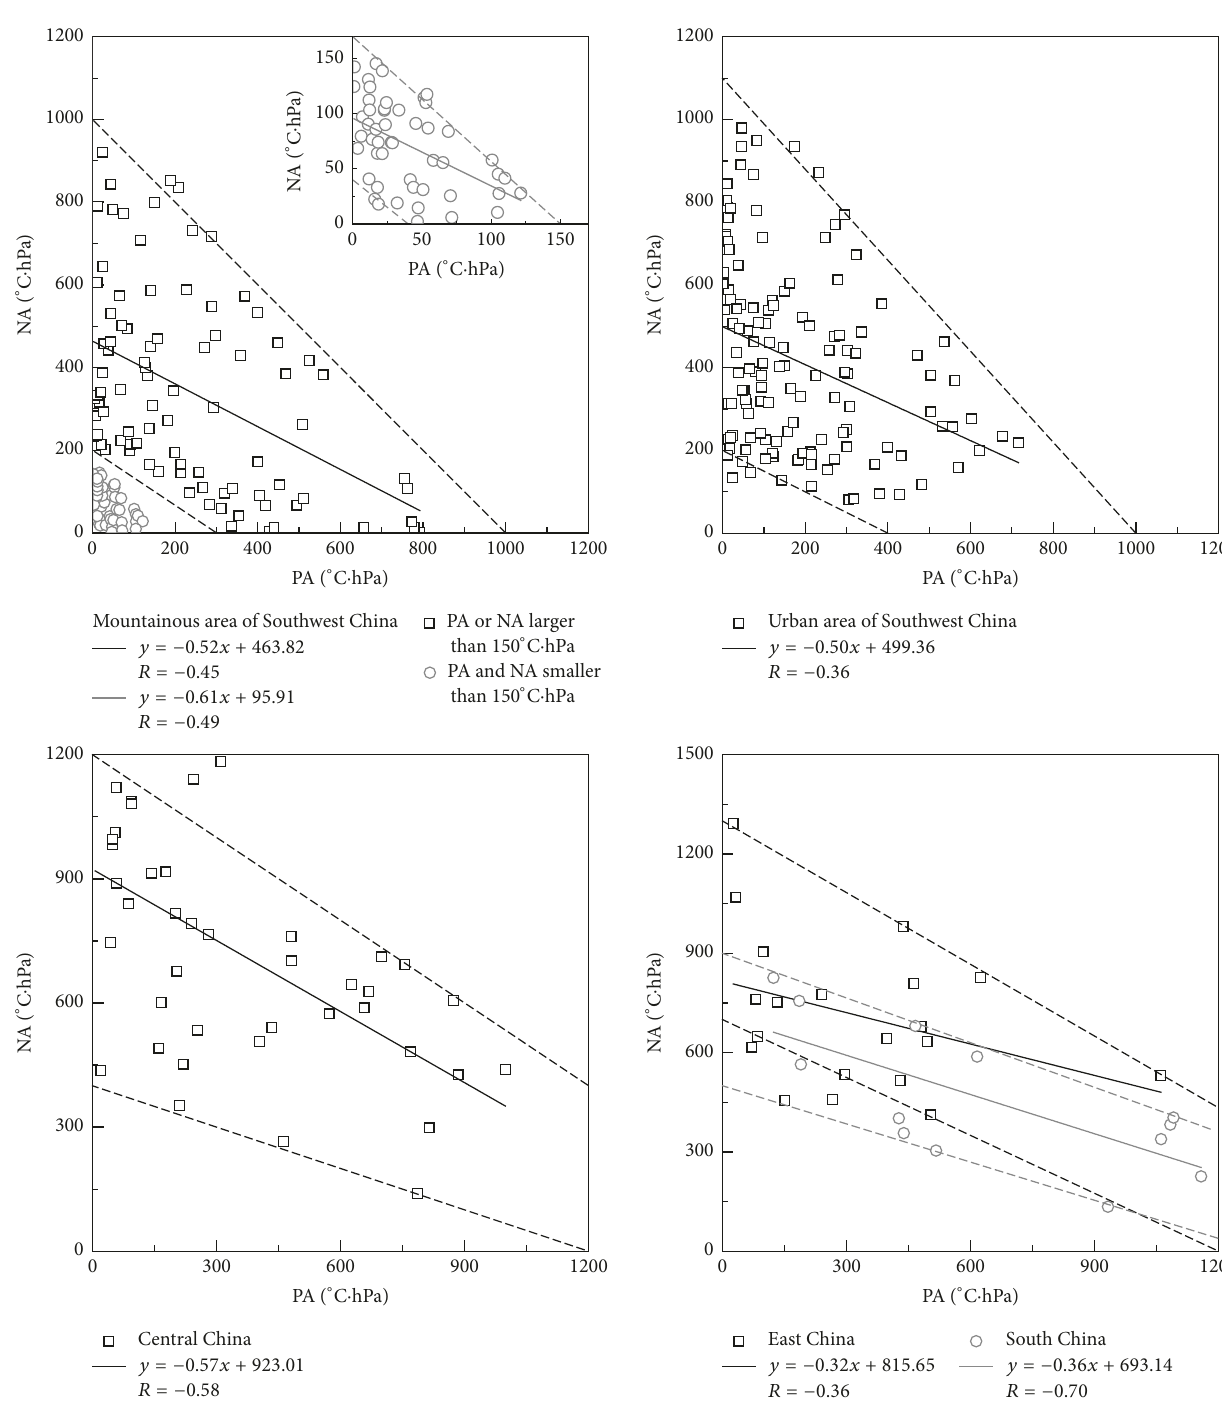
Figure 5: Distributions and relationships of PA and NA during freezing rain events in different regions of China from 2000 to